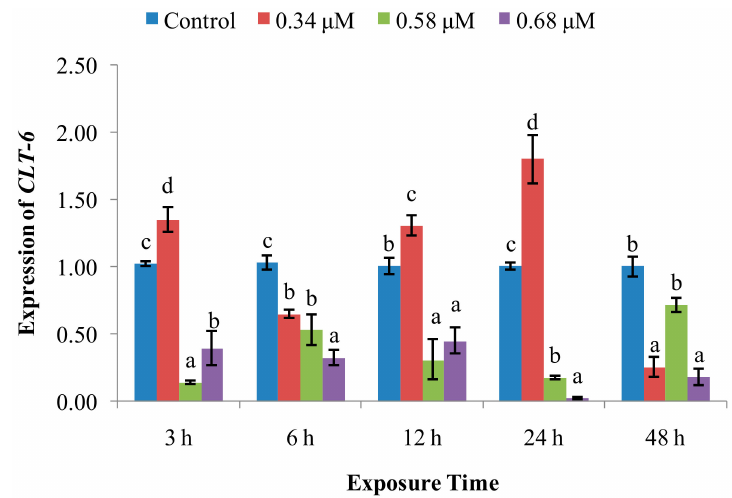
Figure 10. E ff ect of TD 49 on hemolymph expression of CLT-6 at di ff erent time points after exposure to di ff erent concentrations (0, 0.34, 0.58, 0.68 µ M) of TD 49 . Data represent mean ± SD values ( n = 3) at the same time interval, with di ff erent letters denoting significant di ff erences ( p <